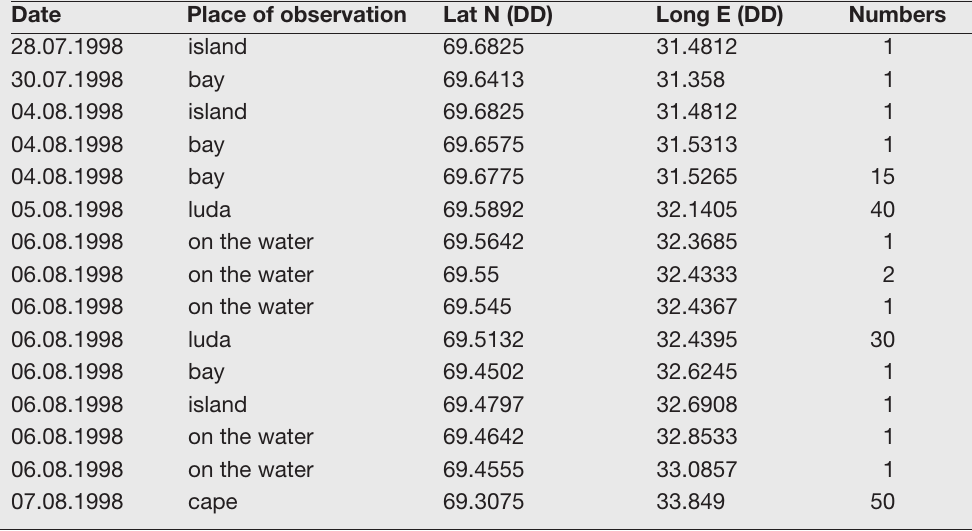
Table 1. Observations of harbour seals along the western Murman coast during summer 1998 (from: Kondakov et al.